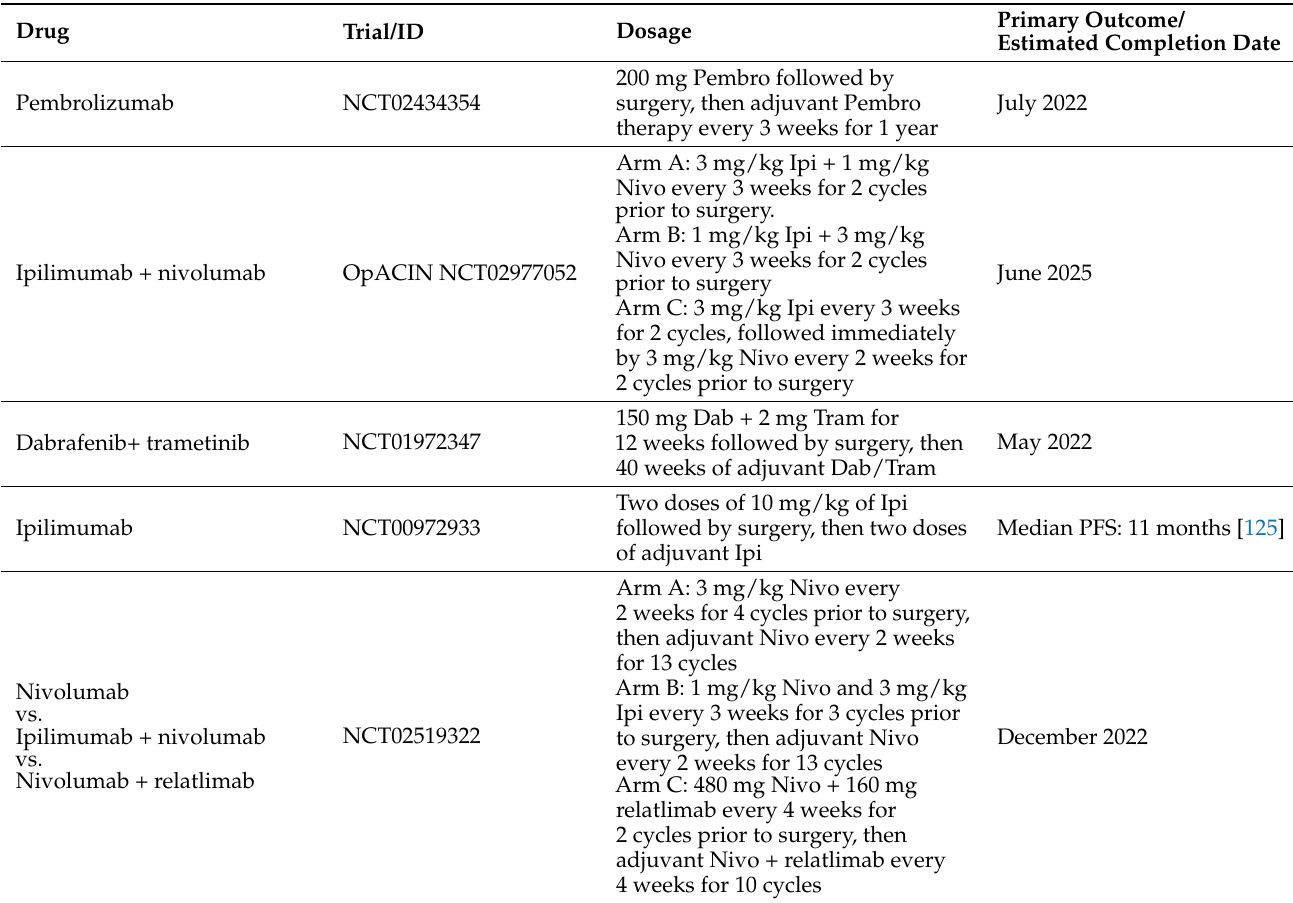
Table 3. Current clinical trials on neoadjuvant therapy for stage iii